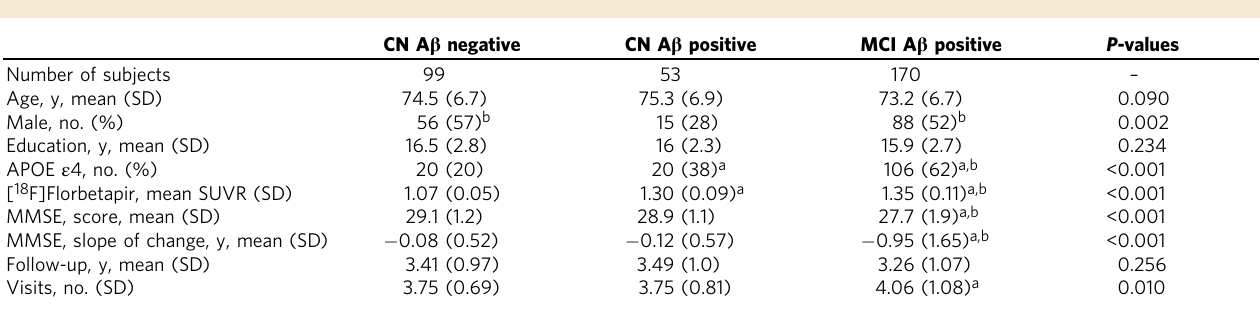
Table 1 Demographics and key characteristics of the